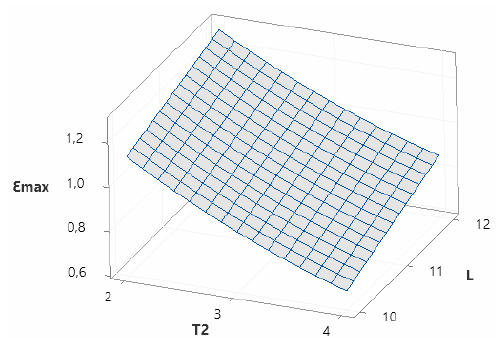
Figure 20. Surface plot of σ max and T 1; T 2 (for L = 11 mm)